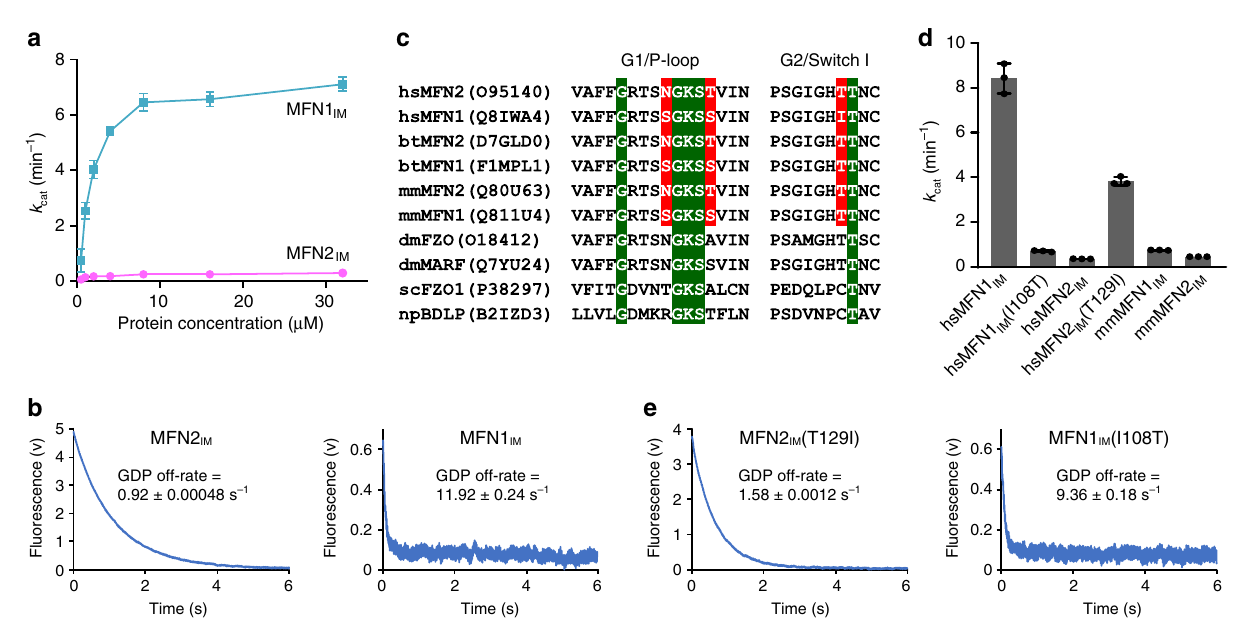
Fig. 2 MFN2 is a weak GTPase. a GTP turnover rates of MFN2 IM and MFN1 IM were measured at seven different protein concentrations. Error bars indicate s.d. ( n = 3). b GDP off-rates of MFN2 IM and MFN1 IM . A representative trace from three independent experiments is shown for each sample. c Sequence alignment of the P-loop and switch I of mitofusins from various species. Conventional motifs/residues are highlighted in green. Residues that differ between human MFN1 and MFN2 and may be responsible for GTP binding and hydrolysis are highlighted in red. hs Homo sapiens, bt Bos taurus, mm Mus musculus, ; dm Drosophila melanogaster, sc Saccharomyces cerevisiae, np Nostoc punctiforme . d GTP turnover rates of wild-type human (hs) and mouse (mm) MFN1 IM /MFN2 IM , and indicated mutants. Error bars indicate s.d. ( n = 3). e GDP off-rates of MFN2 IM (T129I) and MFN1 IM (I108T). Source data are provided as a Source Data fi le